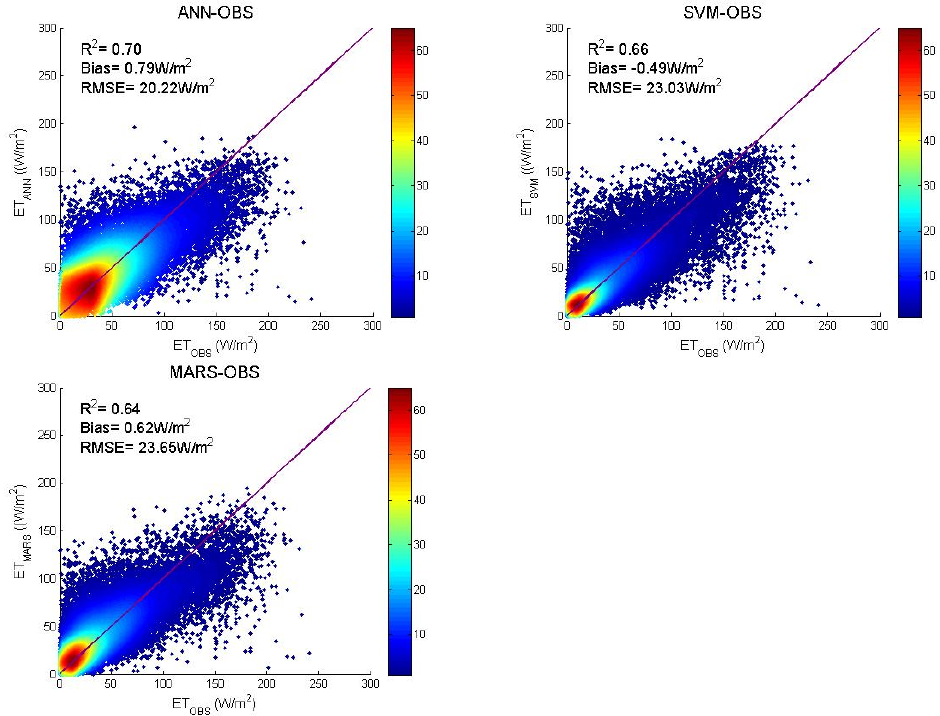
Figure 10. Comparison of daily LE observations for all 85 flux tower sites and LE estimates using different machine learning algorithms driven by MERRA meteorology.